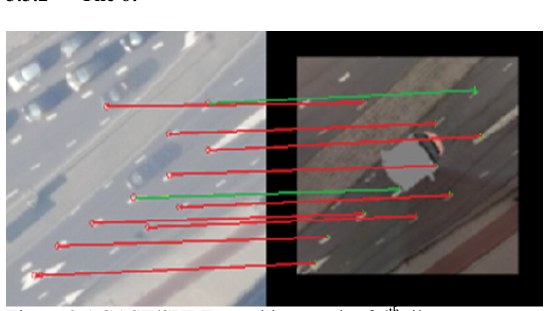
Figure 9 AGAST/SURF matching result of 6 th tile